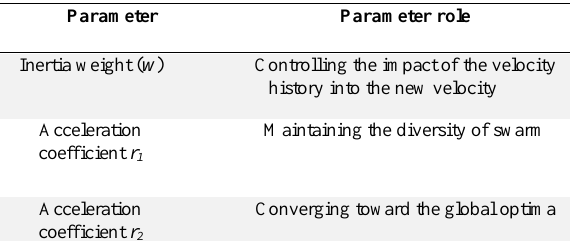
Table 2. Parameters involved in PSO.